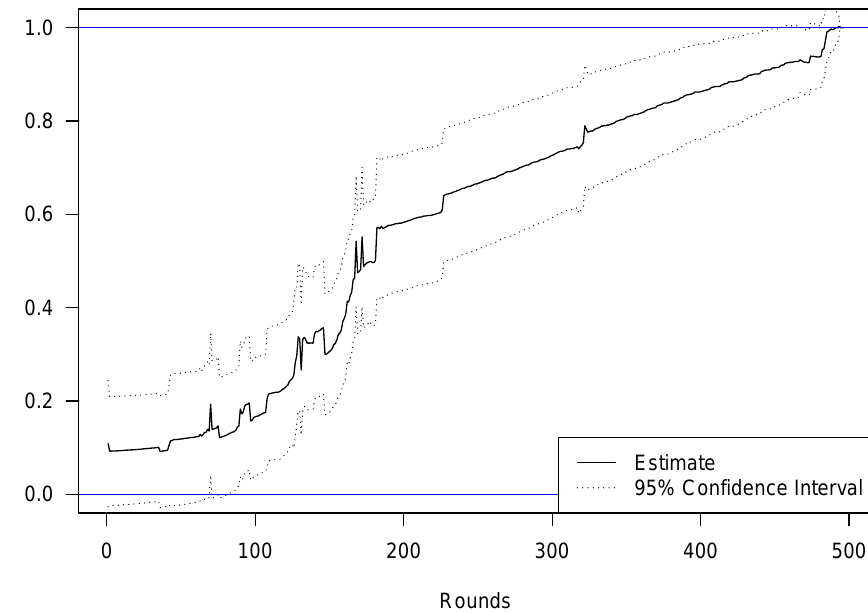
Figure 3. OLS estimate for ˆ β t . The graph shows the OLS estimate for ˆ β t for each point during the auction. The two blue lines indicate the noise hypothesis ( β = 0) and the learning hypothesis ( β = 1). The dotted lines represent the 95%-confidence interval (based on robust standard errors) and demonstrate that the noise hypothesis cannot be rejected in the early rounds whereas the learning hypothesis cannot be rejected towards the end of the auction. The informativeness of prices increases the fastest between round 100 and round 187 when a high number of bids for both frequency bands was